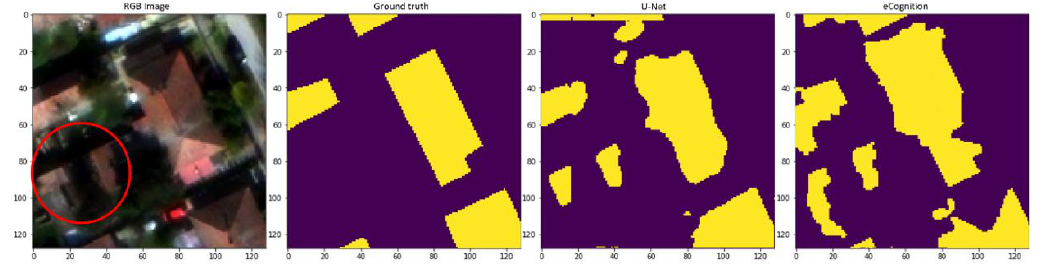
Figure 24. New identified objects.